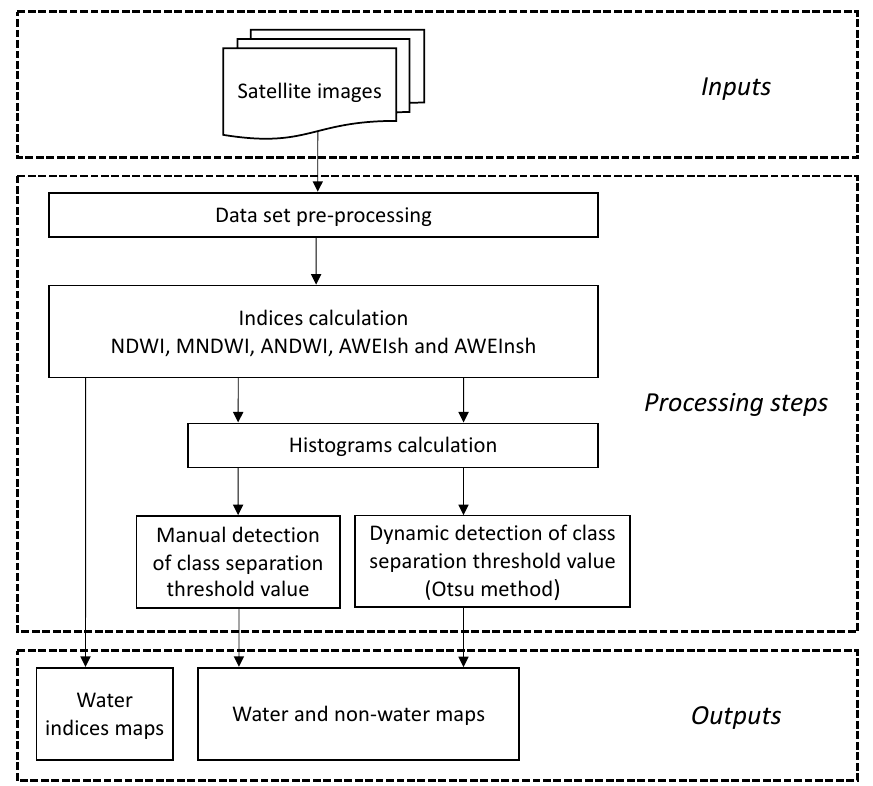
Figure 3. Flowchart illustrating the methodological steps that were carried out in this study for mapping water and non-water (sandbars) surfaces using Sentinel-2 and Landsat 9 satellite